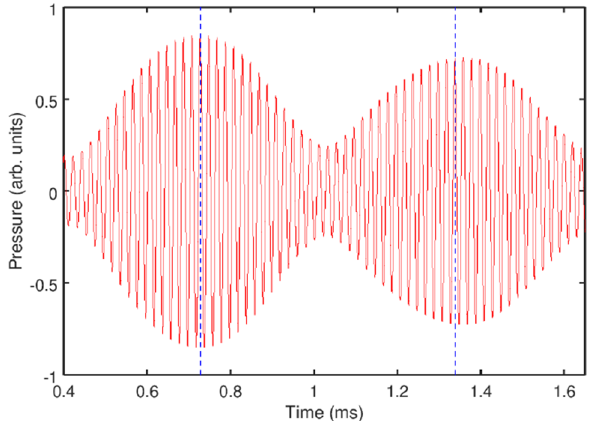
Figure 4. ( a ) Measured acoustic bubble cluster response corresponding to a sinusoidal driving pressure wave 49.2 kHz (twice the frequency in Fig. 3) and amplitude α with the frequency f 0 = 1 / f 0.6 the vertical dashed lines is � T nat ≈ =